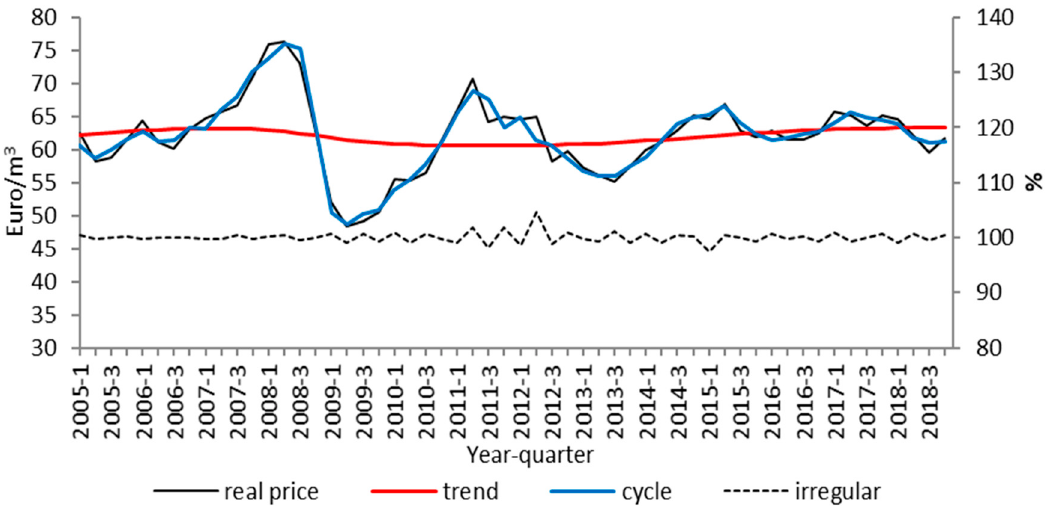
Figure 1. Decomposition of the time series of mean sawtimber prices (for all tree species taken together) in Poland in the years 2005–2018; left axis—cyclical fluctuations and long-term trend, right axis—irregular fluctuations.